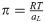
Surface pressure versus area per molecule for an ideal gas model.Experimental (black line) and calculated (red line) π/A per lipid curves for DPPC considering the lipid monolayer as an ideal gas dispersed on an (inert) water surface, according to equation π=RTaL at 25°C (a) and 45°C (b) Experimental data of area per lipid were taken from bibliography and surface pressure calculated by means of the ideal gas equation.